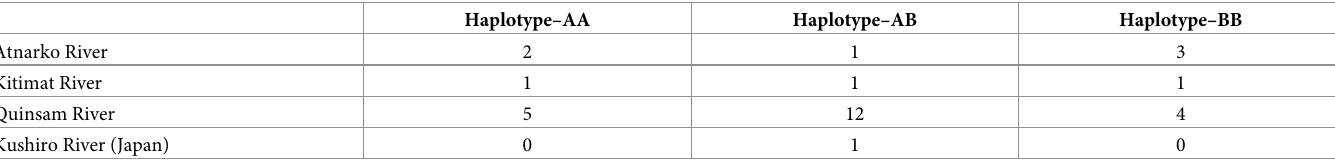
Table 4. Distribution of the LG15_El12.1–15.1 Fst peak haplotypes in odd-year pink